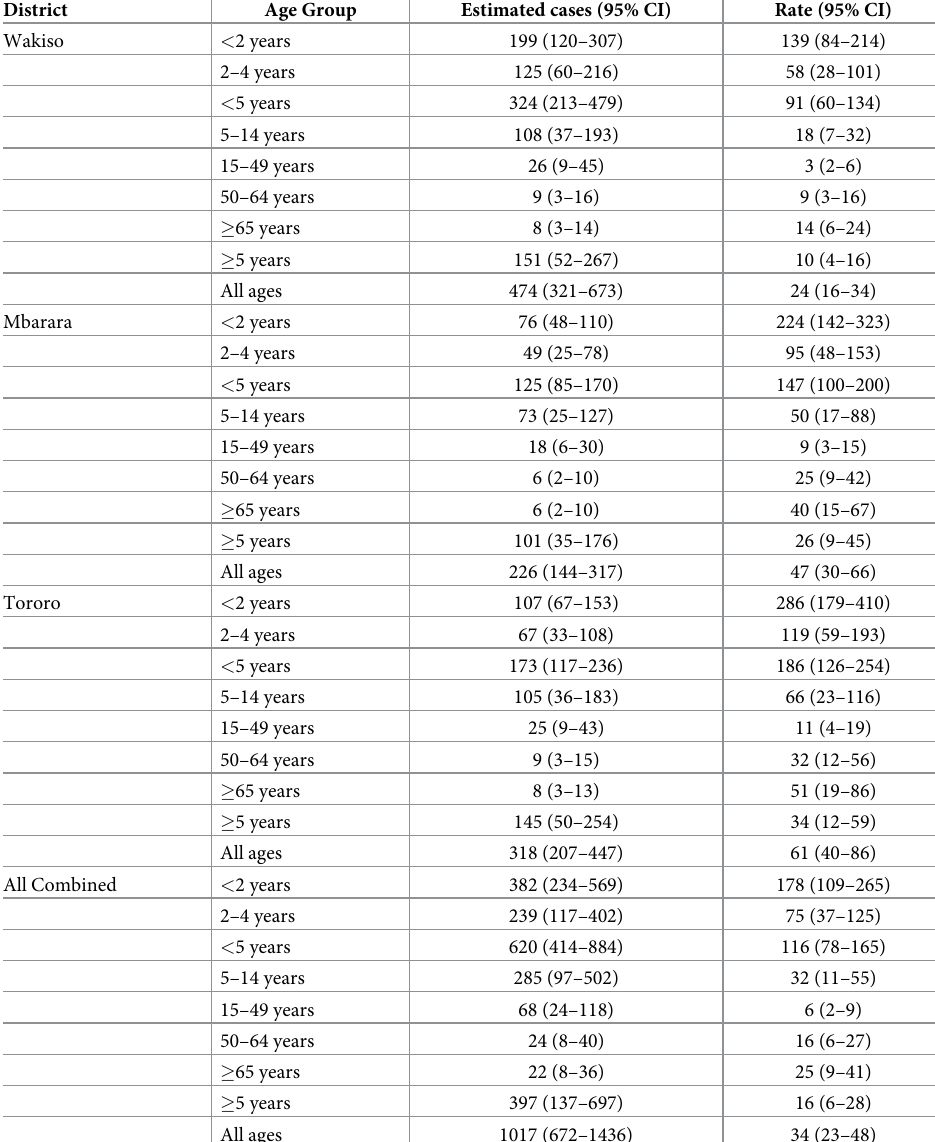
Table 4. Estimated mean annual age-specific number and rate (per 100,000 persons) of influenza-associated pneumonia hospitalizations in three districts in Uganda, 2013–2016.